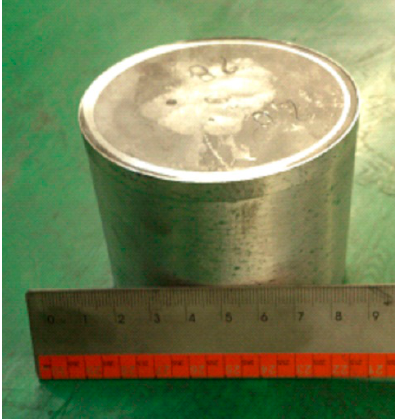
Figure 1. Macrograph of the fabricated semisolid billet of the nano-sized SiCp/7075 composite via rheoforming of the semisolid slurry prepared by ultrasonic-assisted semisolid stirring (UASS).